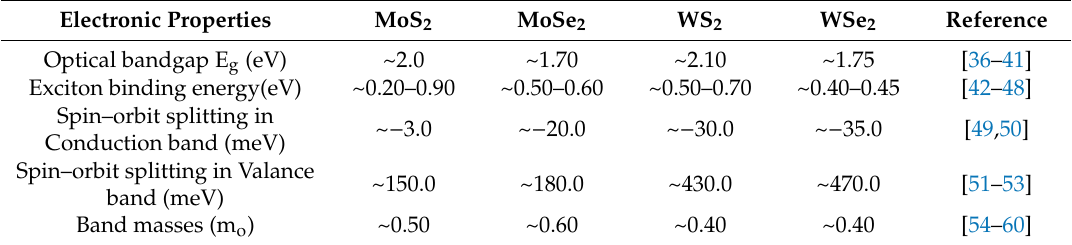
Table 2. Basic electronic characteristics of the various transition metal dichalcogenides (TMDCs) measured both experimentally and theoretically.